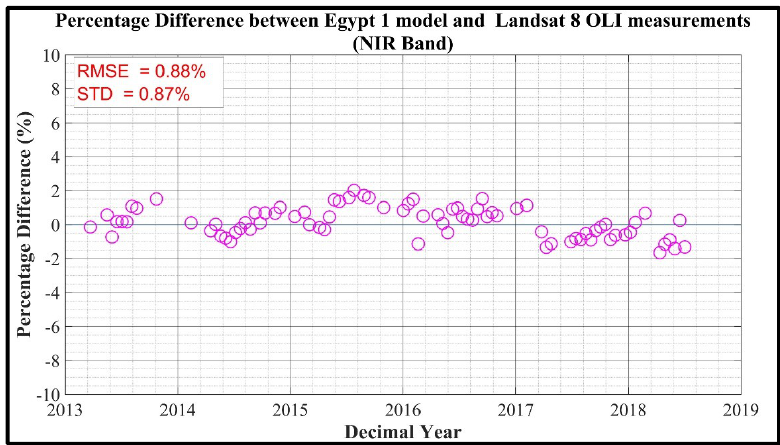
Figure 12. Percentage di ff erence between L8 OLI observations and model